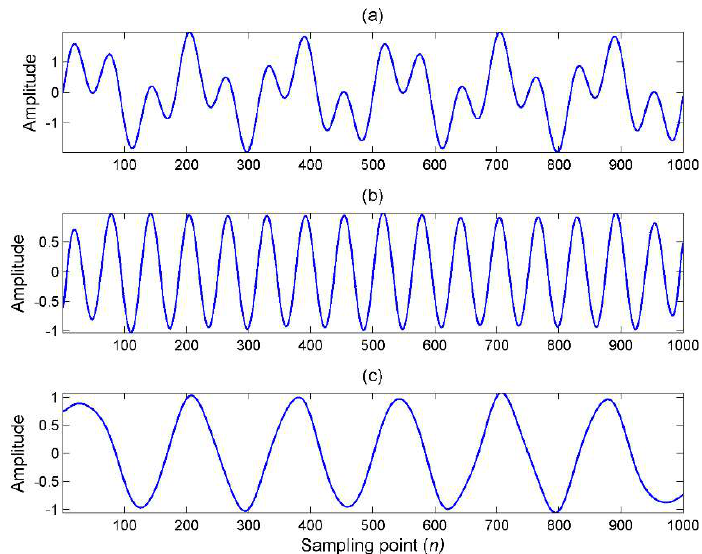
Figure 2. Decomposition of the artificially mixed signal by improved complementary ensemble empirical mode decomposition (ICEEMD): ( a ) the mixed signal; ( b ) IMF1 (intrinsic mode function 1) of the signal; ( c ) IMF2 of the signal.